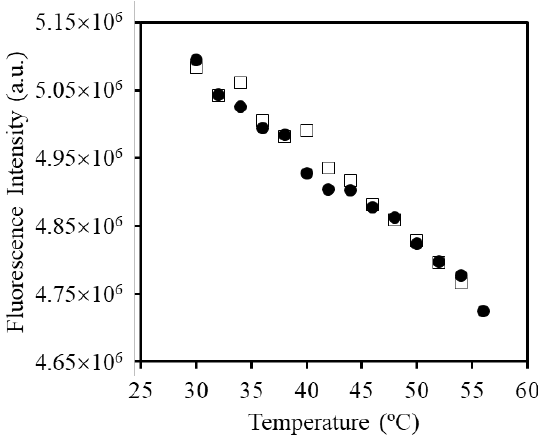
Figure 6. Emission intensity, measured at 610 nm for temperatures between 30 and 56 °C of DNA-ROX (1 × 10 −6 M) by excitation at λ exc = 585 nm. The heating and cooling cycles are represented by circles and squares, respectively.